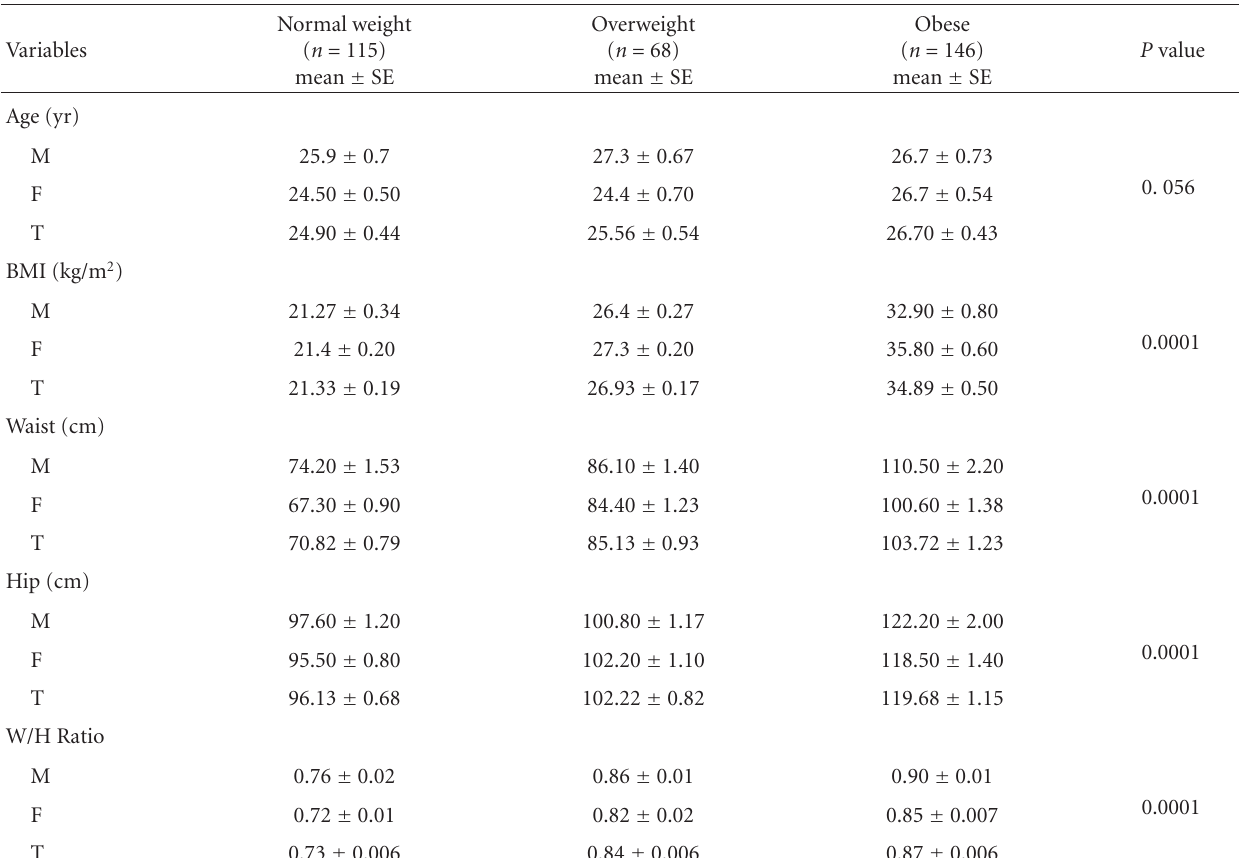
Table 1: Anthropometric characteristics of normal-weight, overweight, and obese male and female subjects (from [28]).